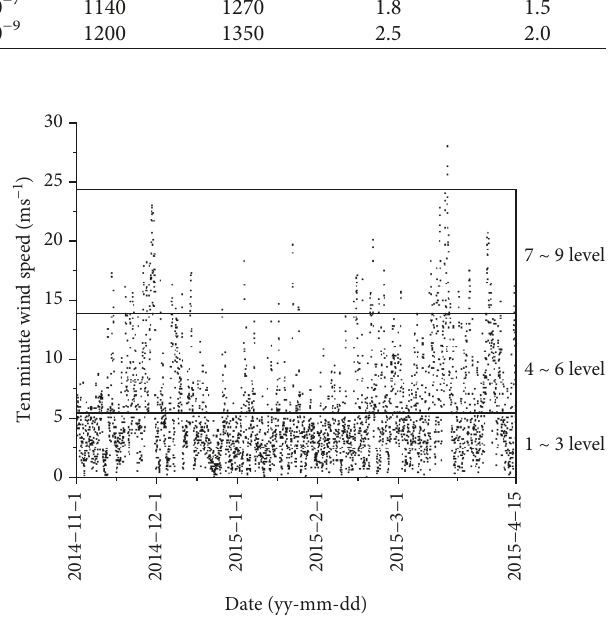
Figure 6: Ten-minute wind speed obtained by Y5854 weather station in winter from 2014 to